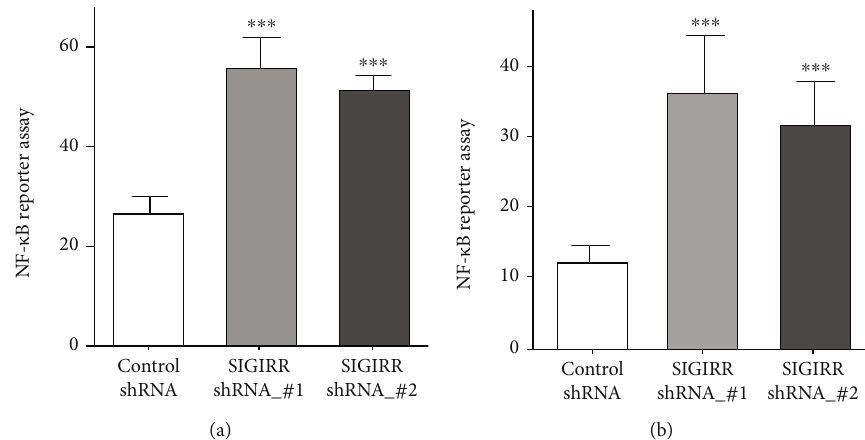
Figure 4: Inhibition of SIGIRR can a ff ect the activity of the NF- κ B pathway in AECs and AMCs. (a, b) NF- κ B report experiments were performed to observe the e ff ect of SIGIRR_shRNA on NF- κ B activity in AECs and AMCs. The data represent three independent experiments with four samples for each treatment. ∗∗ P < 0 : 01 and ∗∗∗ P < 0 : 001